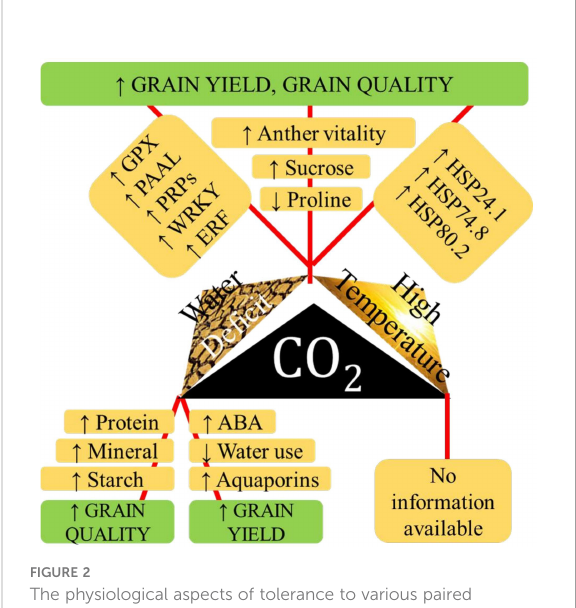
FIGURE 2 The physiological aspects of tolerance to various paired combinations of high temperature, water de fi cit stress and elevated CO2 with respect to grain yiled, and quality in